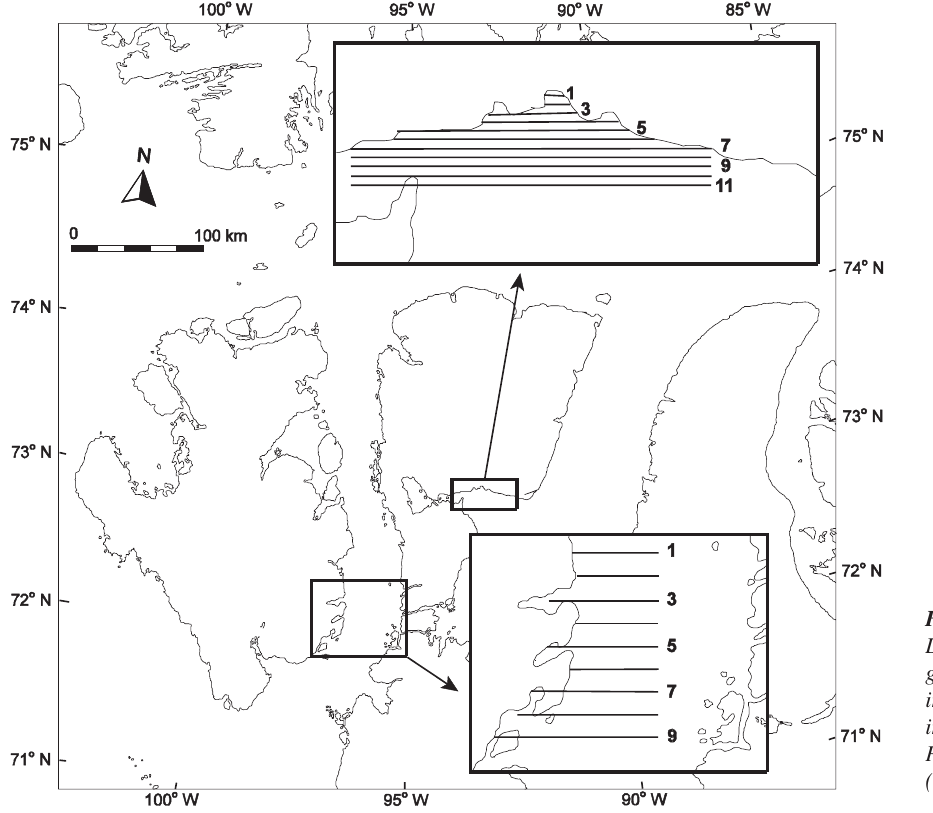
Fig. 4. Locations of photo- graphic transects flown in Creswell Bay (top inset) and in southern Peel Sound (bottom